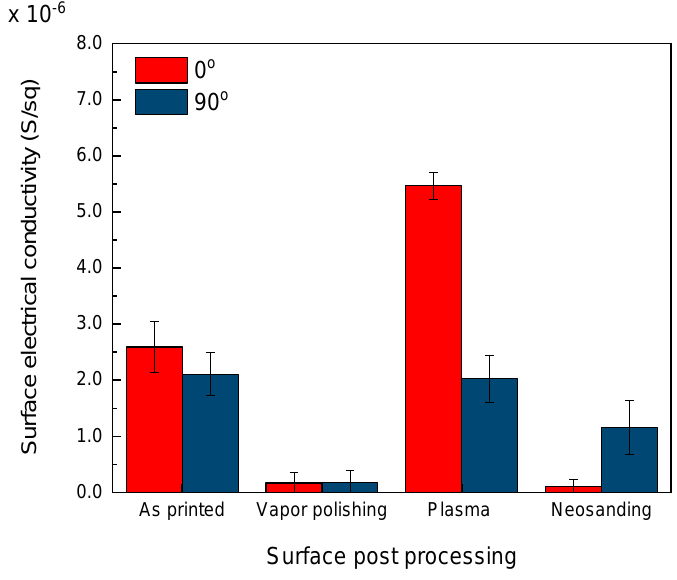
Figure 11. Electrical conductivity of surface post processed parts: as printed, vapor polishing, plasma and neosanding.